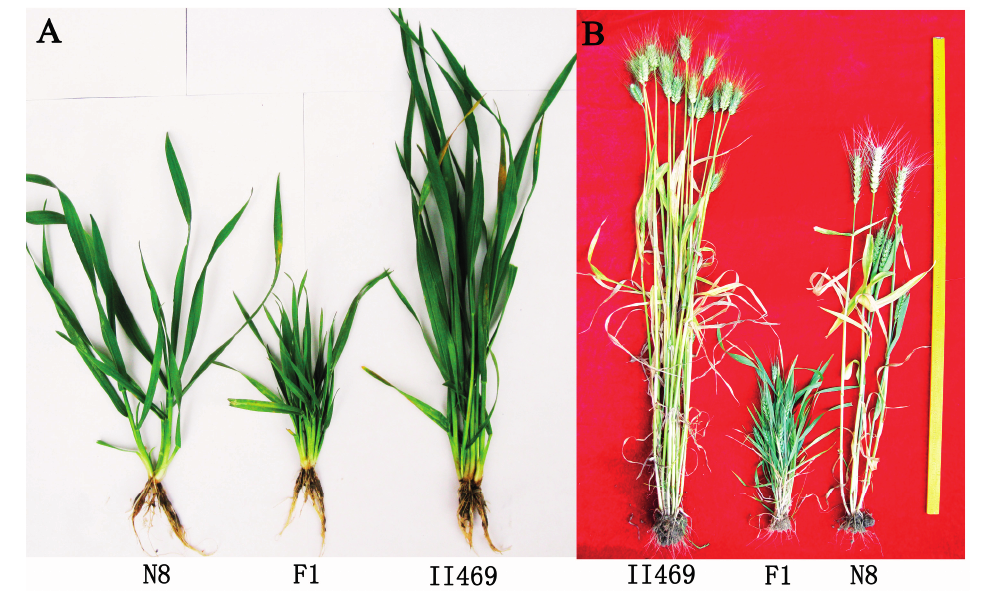
Figure 1. The phenotype of wheat hybrid necrosis F 1 hybrids and its parents, Neimai8 (N8) and II469 at the seedling stage ( A ) and at the harvest stage ( B ).